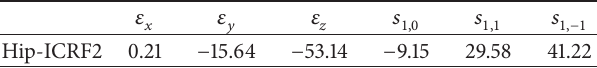
Table 3: Current relations obtained for the Hipparcos-ICRF2 (in